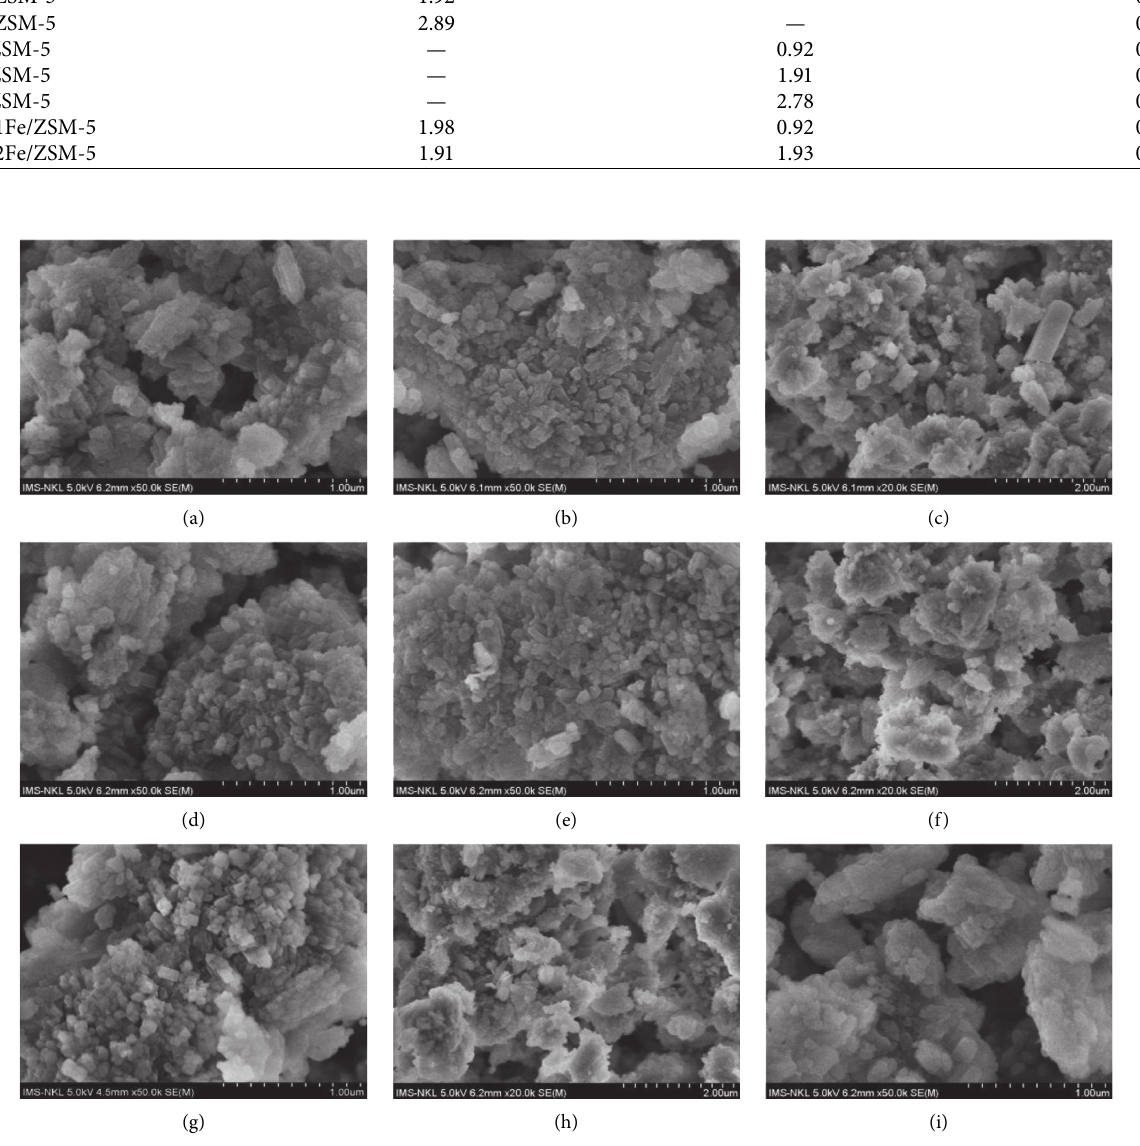
Figure 3: FE-SEM images of all catalysts. (a) 1Cu/ZSM-5. (b) 2Cu/ZSM-5. (c) 3Cu/ZSM-5. (d) 1Fe/ZSM-5. (e) 2Fe/ZSM-5. (f) 3Fe/ZSM-5. (g) 2Cu-1Fe/ZSM-5. (h) 2Cu-2Fe/ZSM-5. (i)